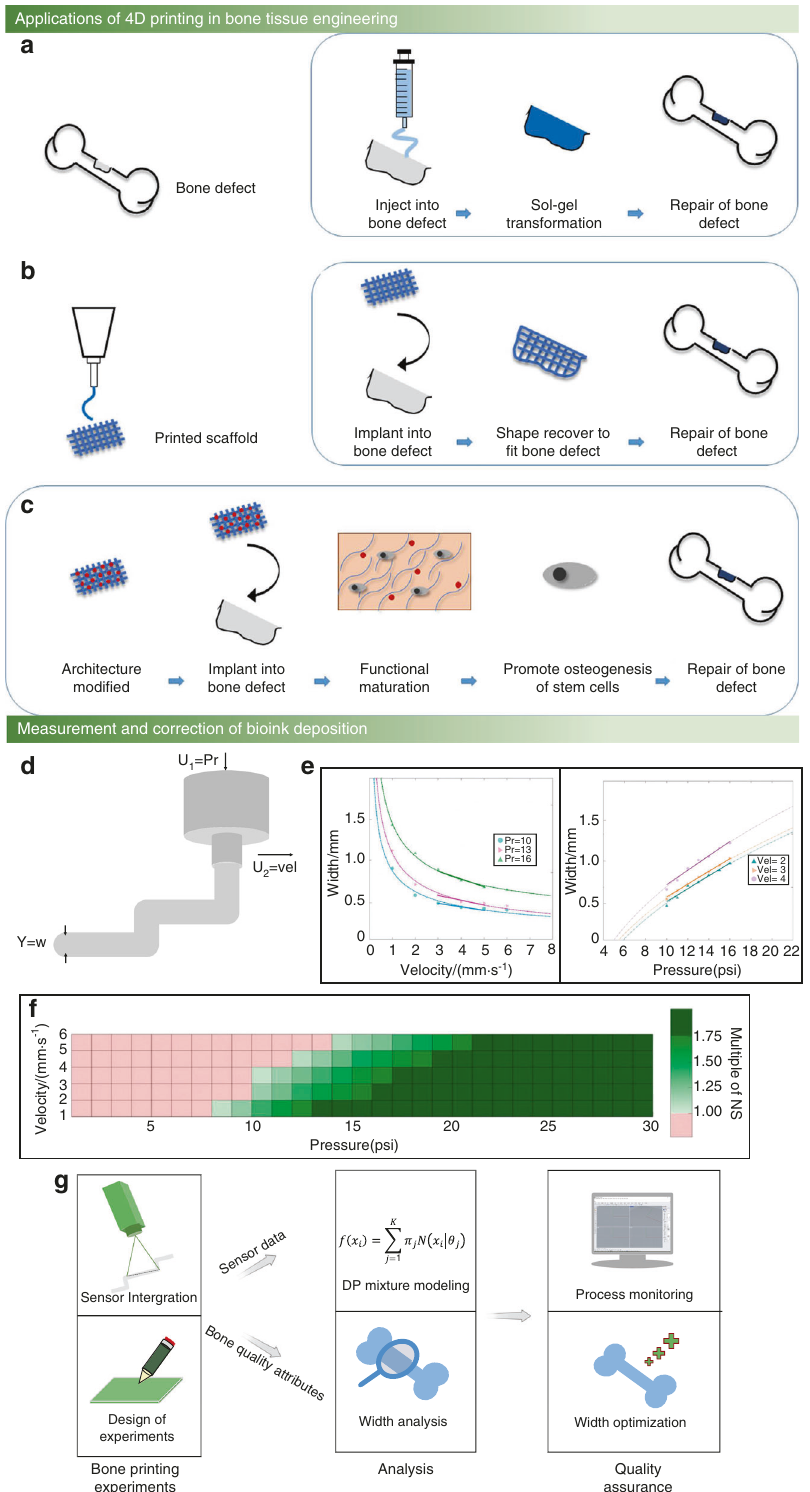
Fig. 3 Measurement and correction of the bone scaffold width. a Examples of injectable thermosensitive hydrogels for 4D bone tissue regeneration. 57 b Examples of the shape memory of 4D printing to repair bone tissue defects. 57 c Bone tissue repair based on the establishment of a biomimetic microenvironment by 4D printing, which induces the functional maturation of neobone tissue and promotes the osteogenesis of stem cells, enhancing the formation of new bone tissue. 57 d Two factors affecting the bioprinting width (w): input pressure (U1) and printing axis moving speed (U2). e The mapping relationship between pressure and width and the mapping relationship between moving speed and width. 59 f The printing width under the combined in fl uence of the extrusion pressure and moving speed. The red area represents a width smaller than the normal width, the dark green area on the right represents a width larger than the normal width, and the middle light green represents a width within the normal range. 59 g Summary of the research approach integrating experimental tests, sensor data, and Dirichlet process modeling for monitoring width control. (Figures adapted with permission from Wan et al. 57 and Armstrong et al. 59